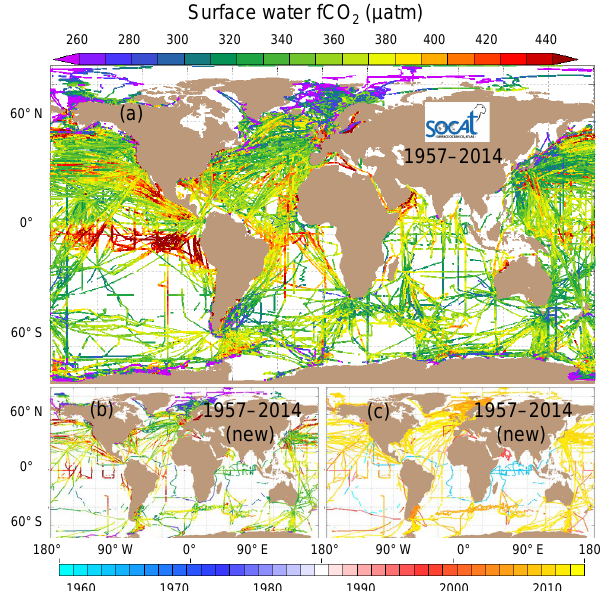
Figure 1. Global distribution of (a) all and (b) newly added surface water f CO 2 values (µatm) and (c) the timing of the newly added data sets in SOCAT version 3 with data set flags of A to E. Version 3 has data sets from 1957 to